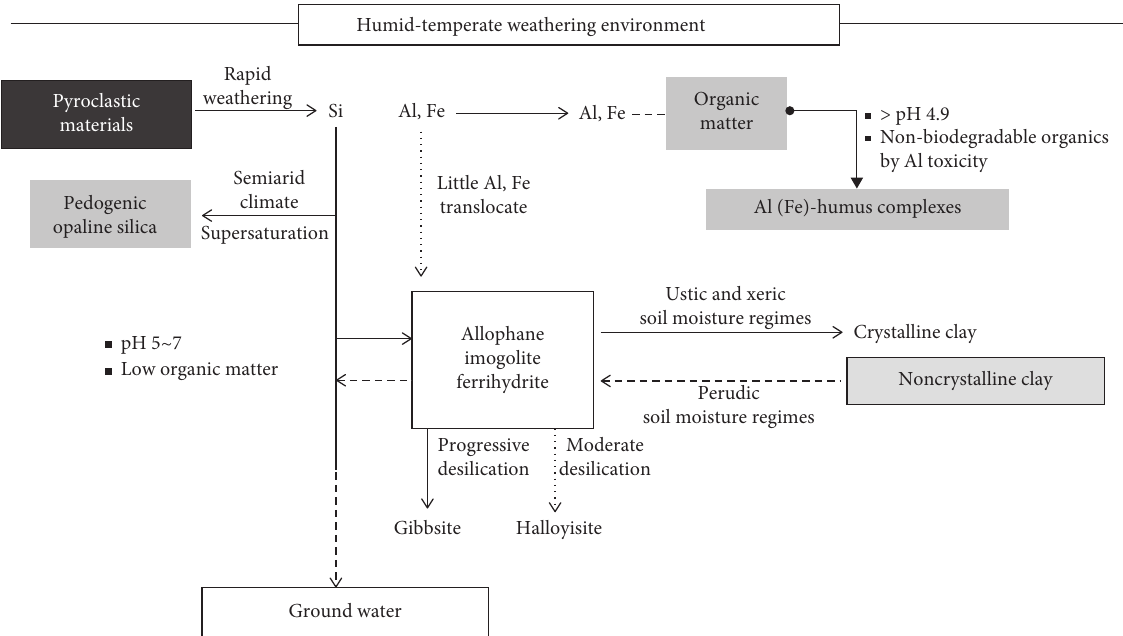
Figure 6: Schematic illustration of the possible formation and transformation of clay minerals and humus complexes in volcanic ash soils derived from pyroclastic materials in a humid-temperate climate on Jeju